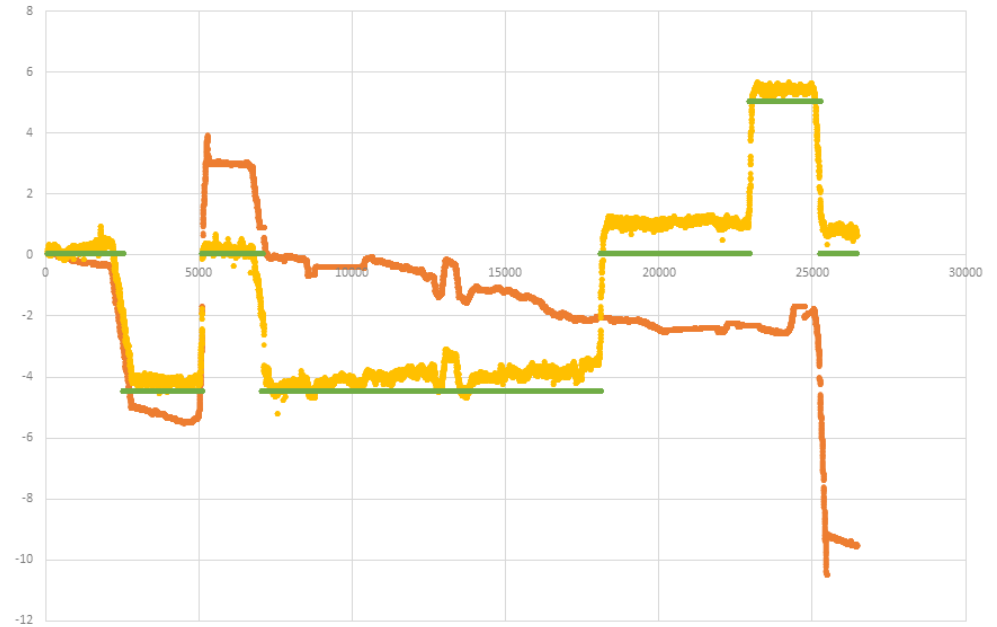
Figure 5. Height in meter over time, as measured by optical-flow sensor (orange), barometer sensor (yellow), and ground truth (green), demonstrate the superiority of the barometer-sensing method: The barometer’s accuracy was more than 1 m, whereas (due to varying light conditions) the optical flow performed poorly. Algorithm 2: Floor-change algorithm: if the user had been going up or down, the algorithms estimate the elevation change between the current z and the last flat-floor parameter. As long as the user remains in a flat, minor changes in the measured elevation are omitted. A vertical velocity of [ 0.20, 0.25 ] m per s, is a common value for C up and C done assuming a walking user. Init: Let z 0 be the init barometer elevation